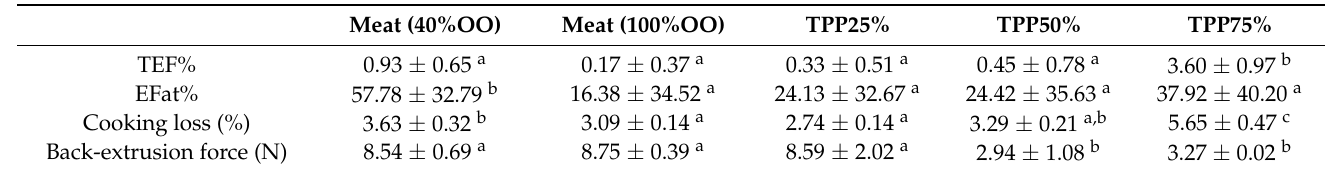
Table 2. Mean values (+SD) of emulsion stability, cooking loss, and emulsion texture for all frank- furter